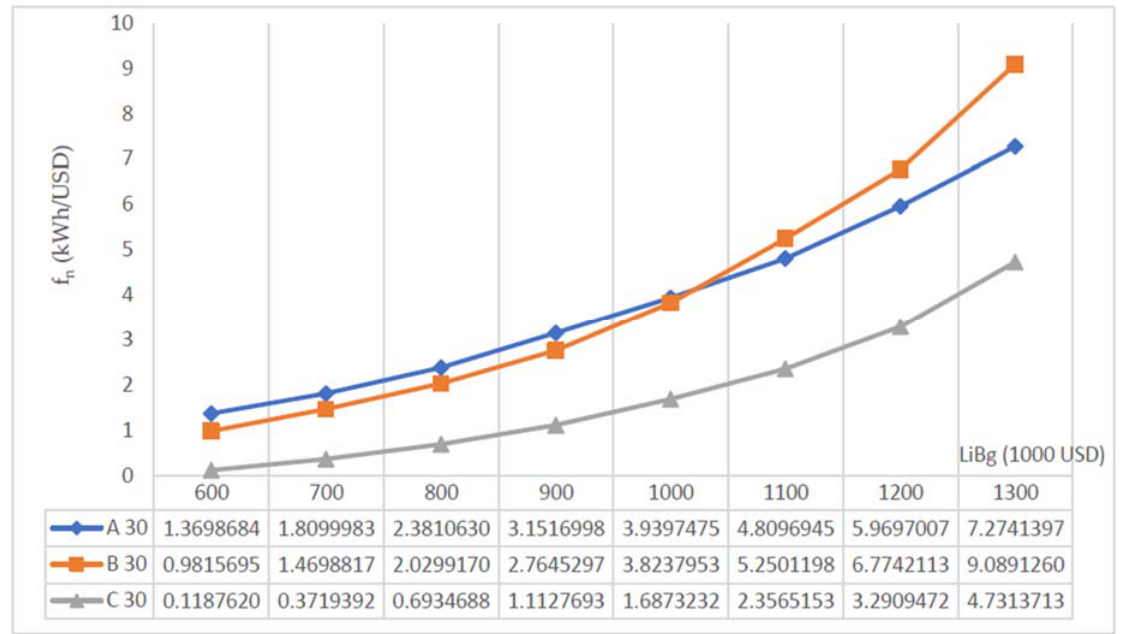
Figure 8. f i,n with t = 30 years in the most disadvantaged situation (electricity price increasing by +20% and residual value by − 20%).